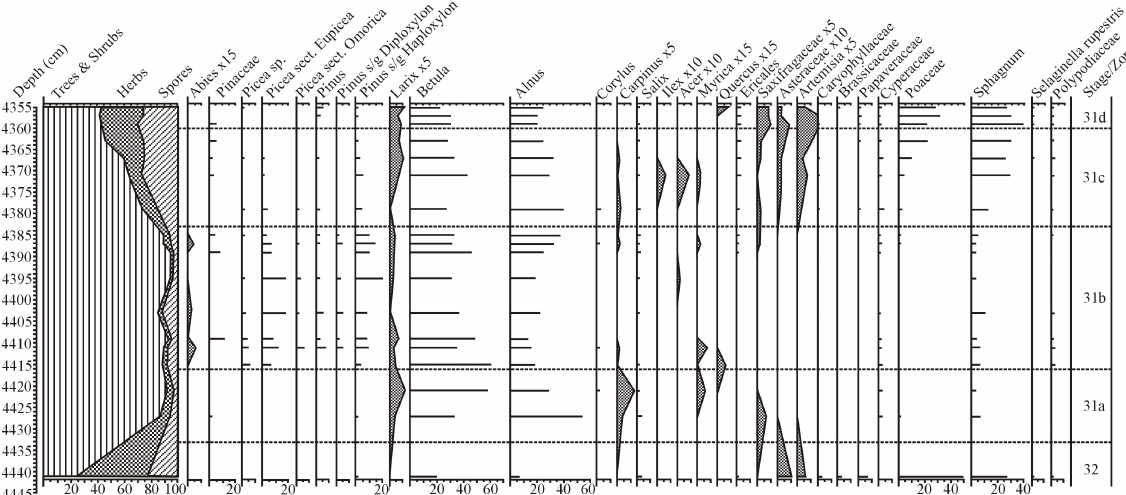
Fig. 4. Percentage diagram of select taxa from MIS31. The climatic optimum is represented by zone 31b. Results are from core ICDP 5011.